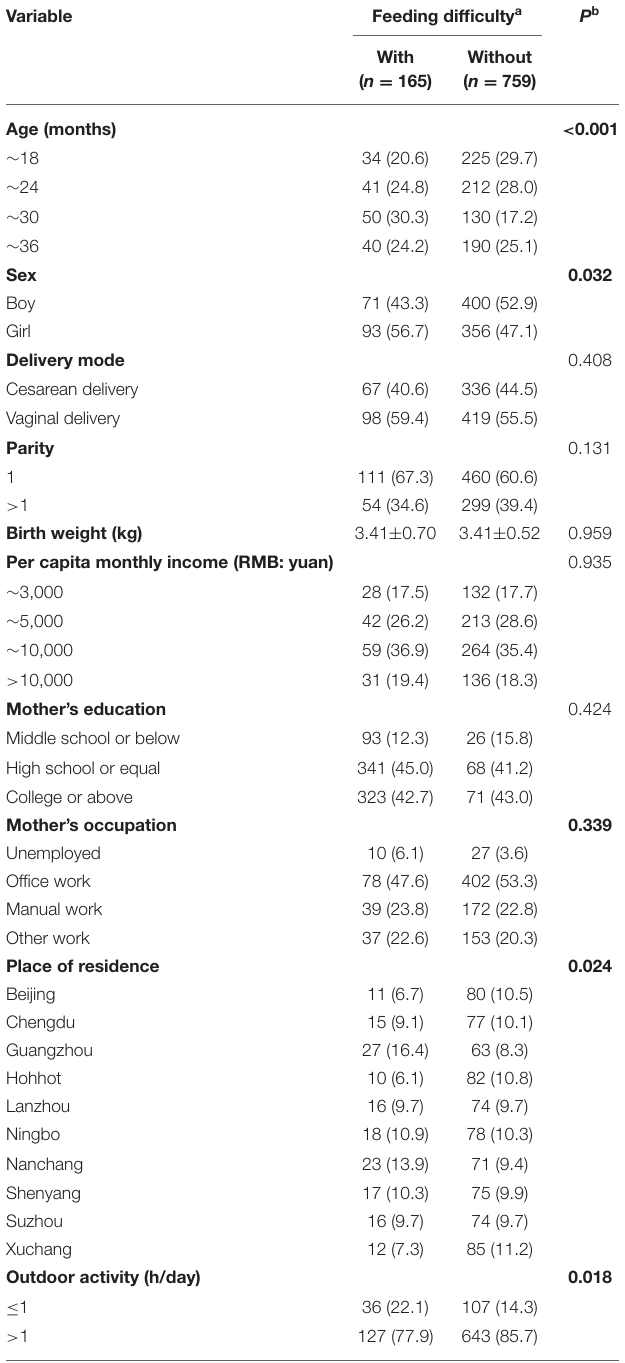
TABLE 1 | Socio-demographic characteristics of children with or without feeding